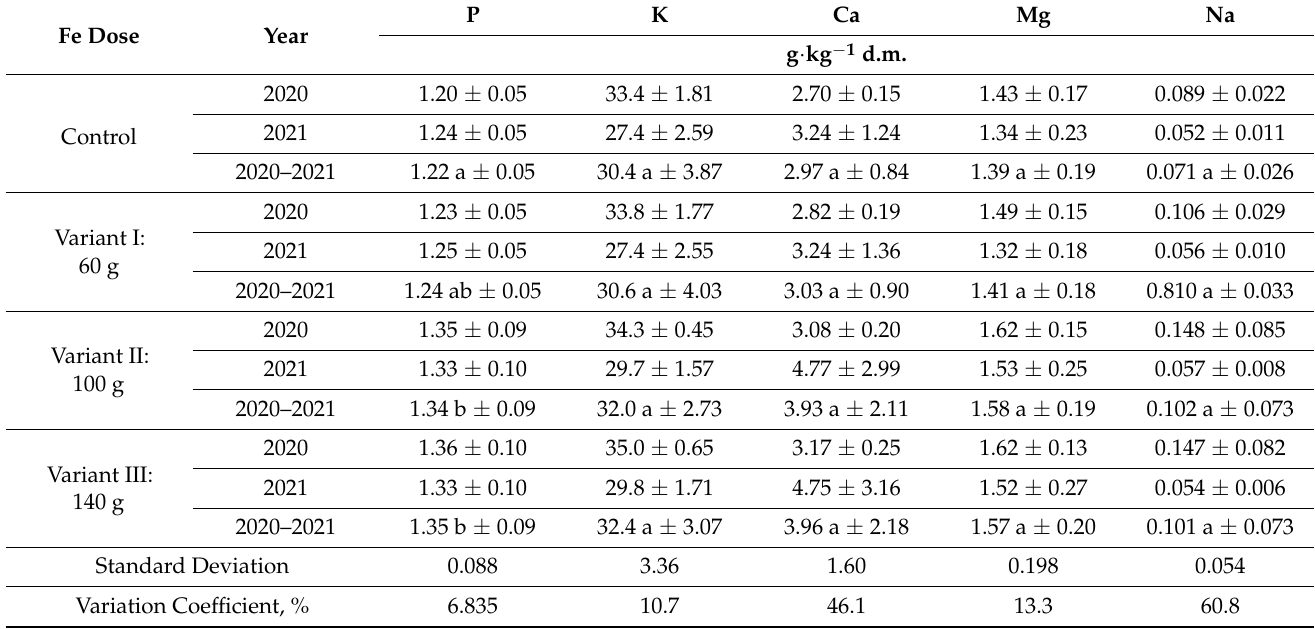
Table 5. Effect of Fe fertilization on the macroelement content in